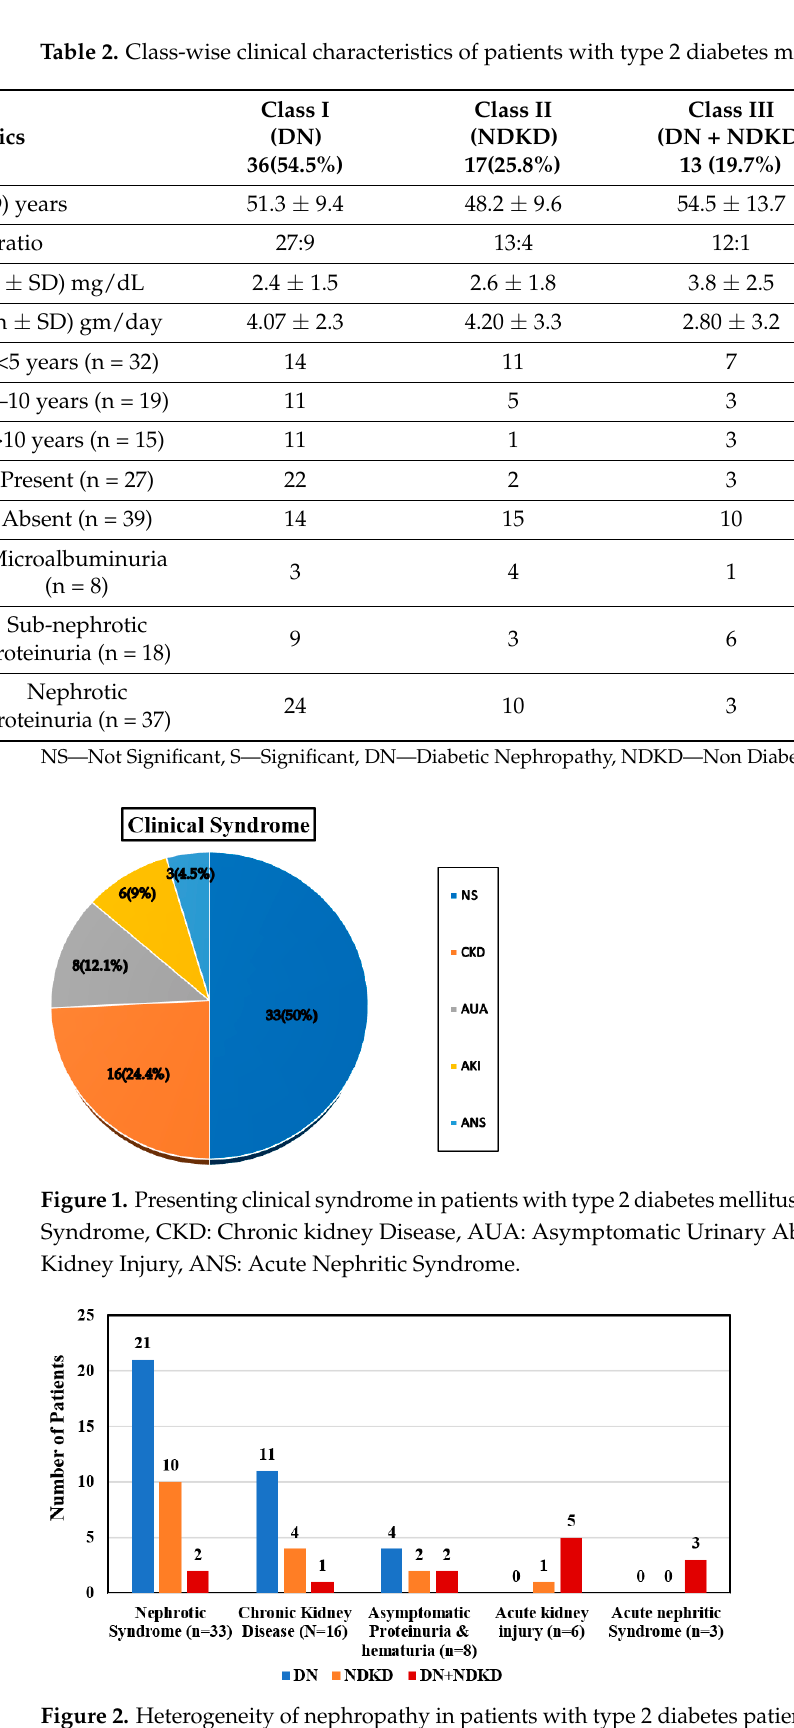
Characteristics